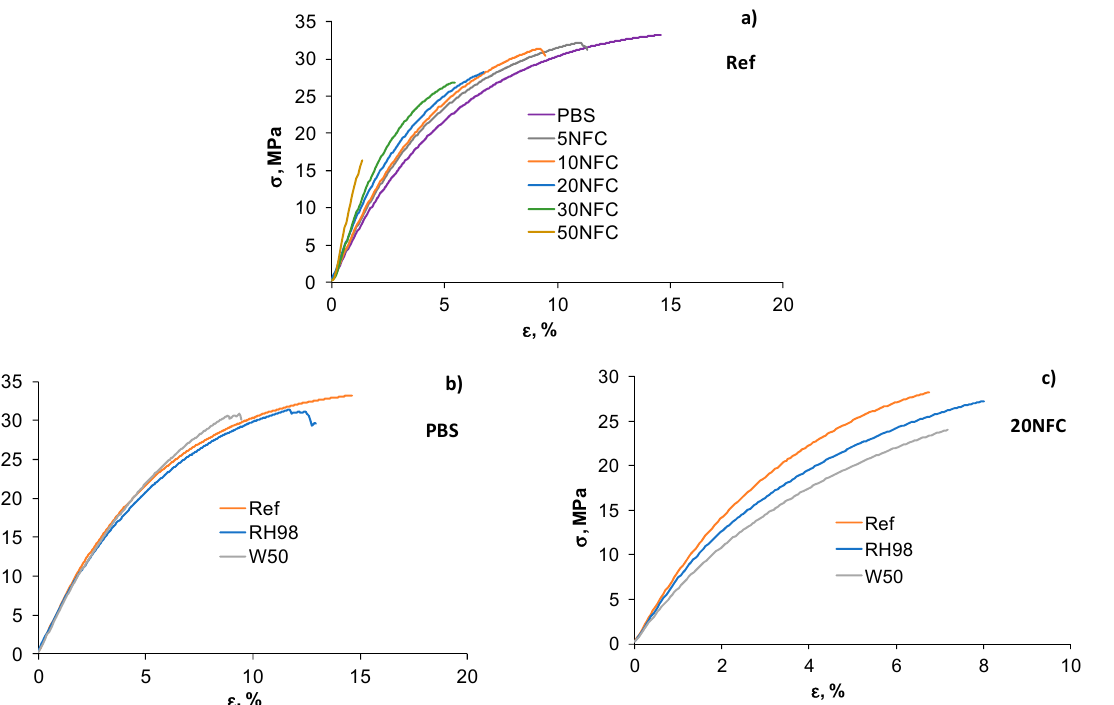
Figure 4. Stress–strain diagrams for reference PBS/NFC composites ( a ) and aged PBS ( b ) and 20NFC ( c ) samples.